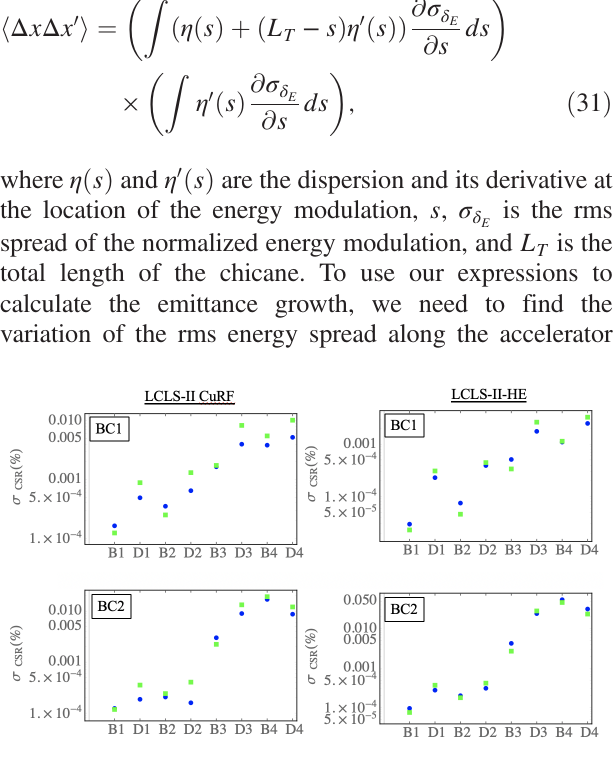
FIG. 10. The Log-Log plots of the CSR rms energy spread for each bend and drift element in the LCLS-II CuRF and LCLS-II first (BC1) and second (BC2) bunch compressors. The blue markers are obtained from ELEGANT simulations and the green markers our expressions.